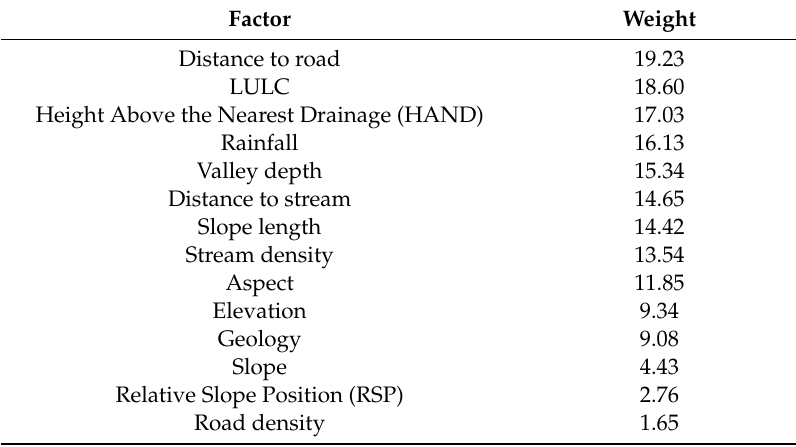
Table 4. Relative influence of e ff ective conditioning factors in the random forest (RF) model.